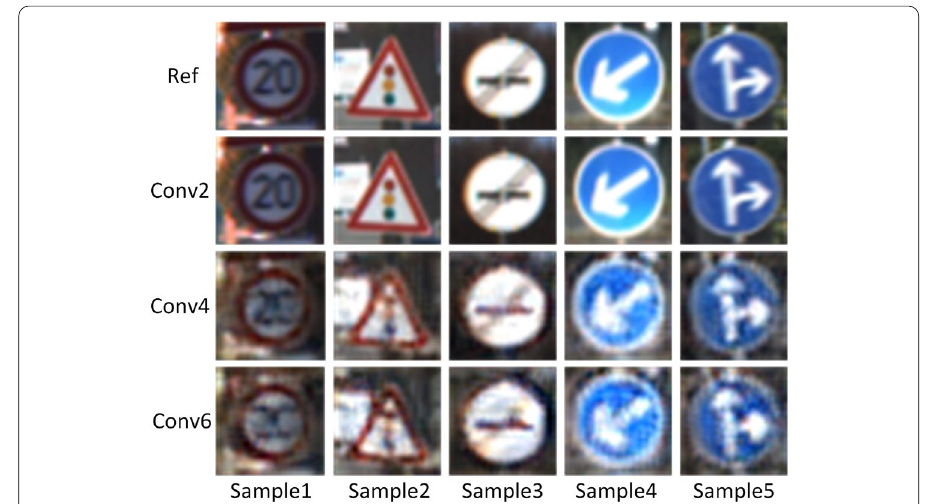
Fig. 3 Recovered images via black-box reconstruction attack